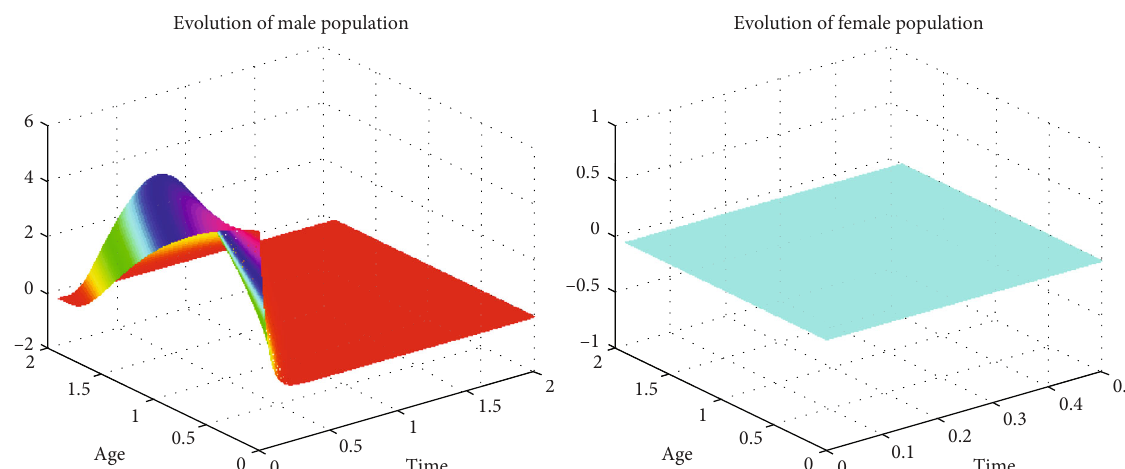
Figure 2: Evolution of the uncontrolled system from a = t = 0 to A = t = 2 .